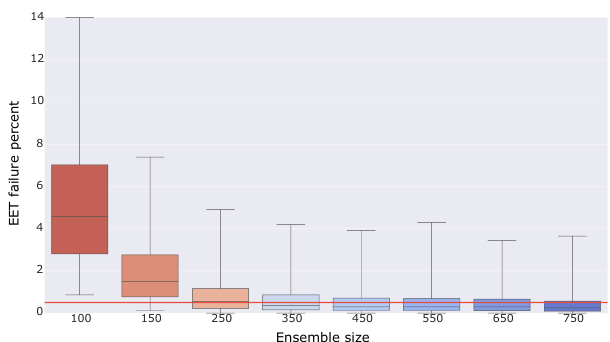
Figure 3. Box plot of EET failure rate distributions as a function of ensemble size. The distributions are generated by randomly select- ing a number of simulations (ensemble size) from a set of 801 simu- lations to compute PC loadings. From the remaining set, 30 simula- tions are chosen at random. These simulations are projected into the PC space of the ensemble and evaluated via EET. For each ensem- ble size, 100 ensembles are created and 100 experimental sets are selected and evaluated. Thus each distribution contains 10000 EET results (40600000 total tests per distribution). The red horizontal line indicates the chosen false positive rate of 0.5%.